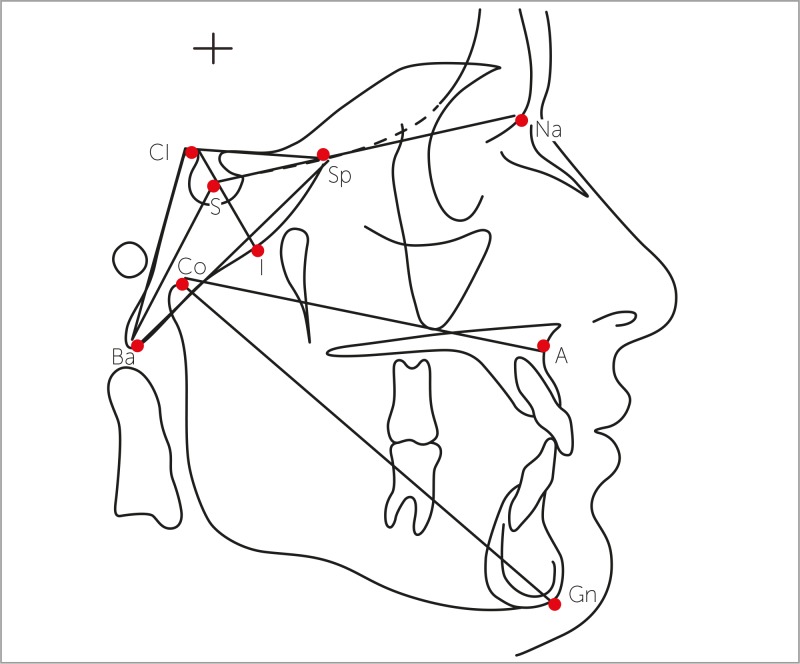
Cephalometric landmarks, linear and angular measurements.